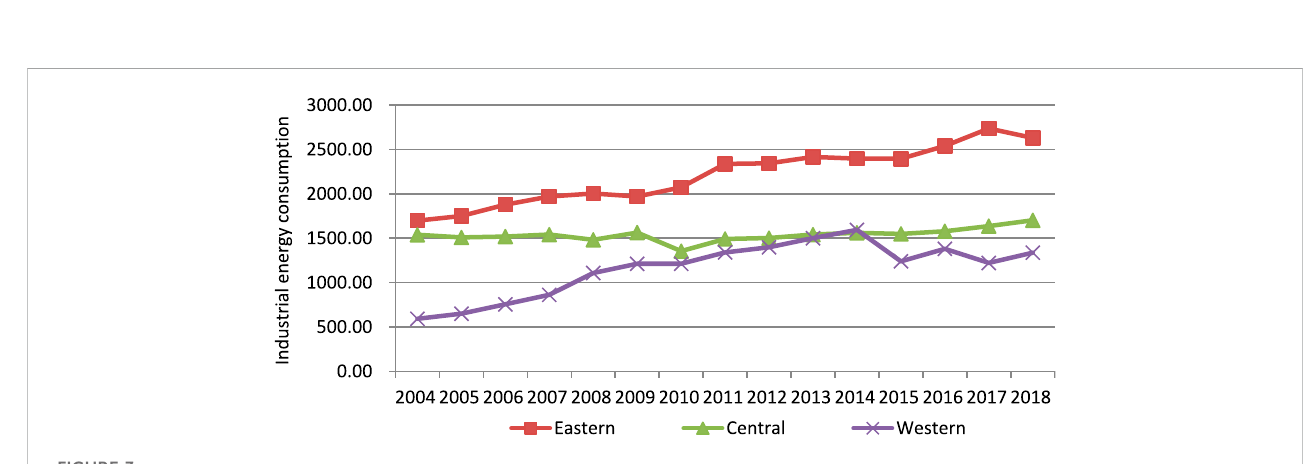
and eastern regions. The ef fi ciency value of the central region is basically higher than the other two regions after 2014, because the environmental pollution in the central region was more serious during 2004 – 2007, and its environmental pollution level